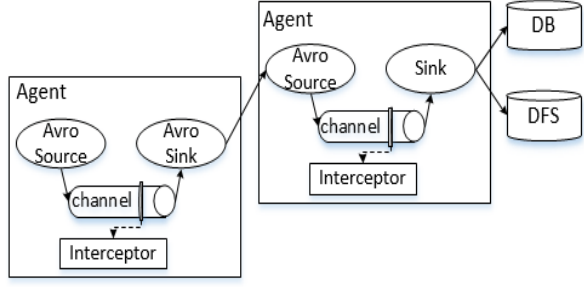
Figure 1. Structure of Flume